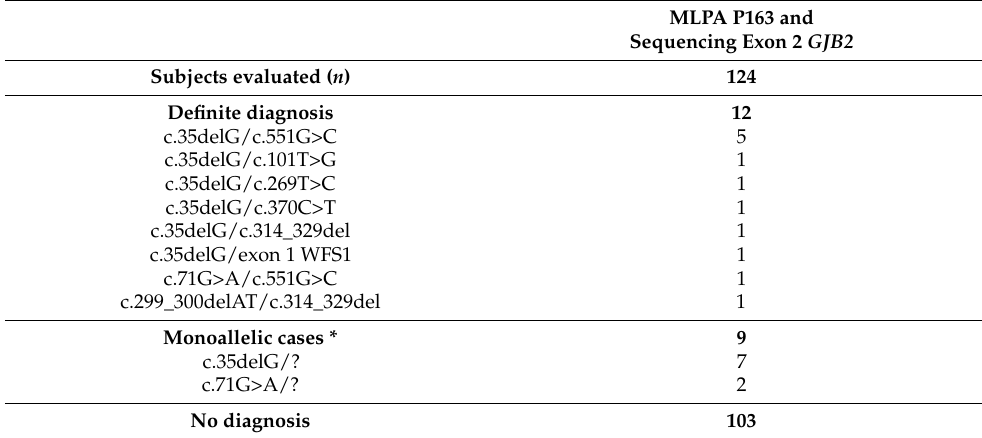
Table 2. Diagnosis results for using MLPA P163 and sequencing of open reading frame of exon 2 GJB2 gene as second-tier diagnostic means, following targeted PCR for common